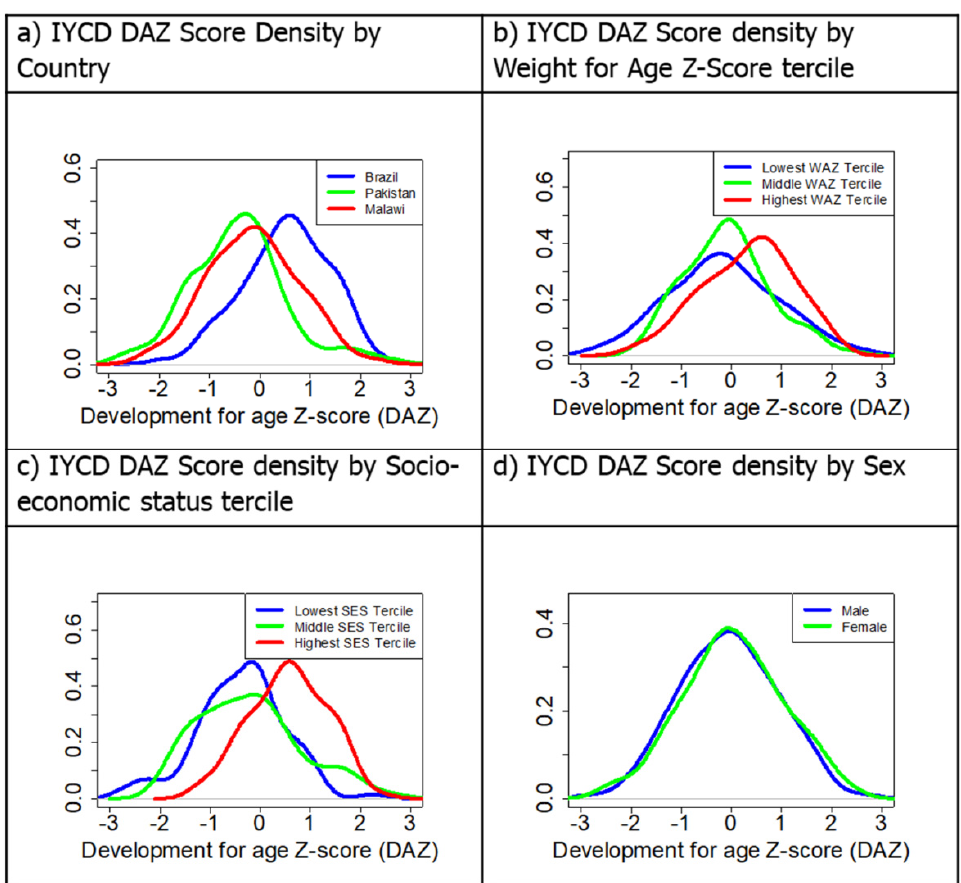
Figure 5. Density plots of development-for-age z -scores (DAZ) by country, WAZ, SES and Sex. ( a ) Development for age z score by country, ( b ) development for age z score varying by weight for age z scores broken into terciles, ( c ) development for age z score by socioeconomic status broken up into terciles and ( d ) development for age z score by sex.